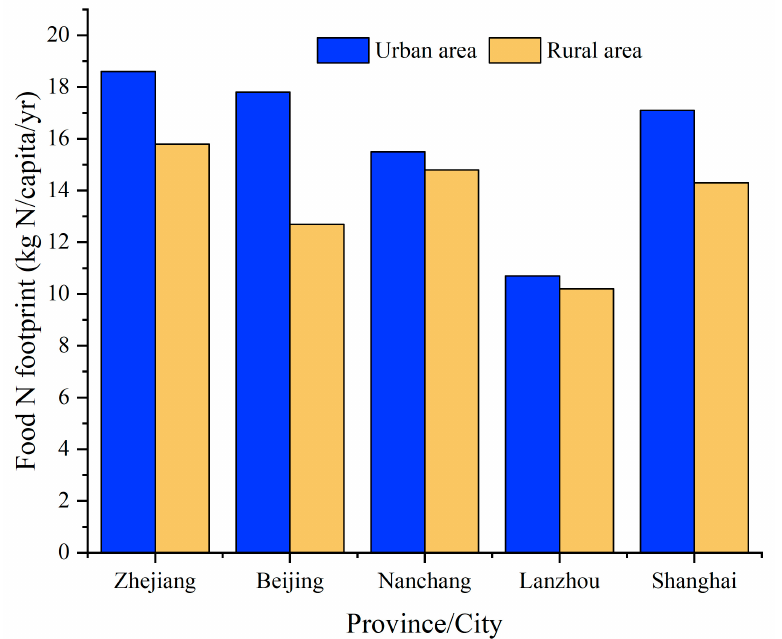
Figure 6. N footprints per capita in urban and rural area in some provinces of China.